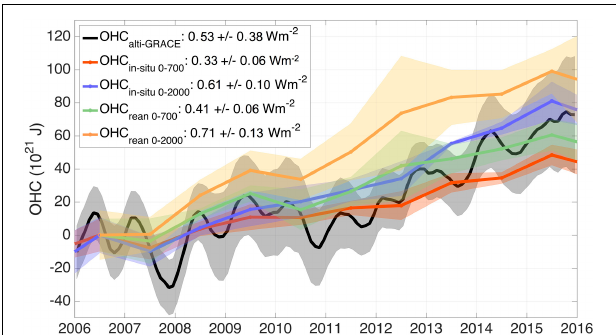
FIGURE 11 | Global mean smoothed (5-month running average) monthly anomalies of OHC derived from alti-GRACE (cid:49) SL thermo (black, OHC alti − GRACE ), annual mean OHC over the 0–700 m ocean column based on six in situ datasets (OHC in situ , red), annual mean OHC over the 0–2000 m ocean column based on four in situ datasets (OHC in situ , blue), annual mean OHC over the 0–700 m ocean column based on three ocean reanalyses (OHC rean , green), annual mean OHC over the 0–2000 m ocean column based on three ocean reanalyses (OHC rean , orange). For OHC rean and OHC in situ , the shading indicates the spread between timeseries (1.65-sigma). The trend uncertainties represent 5-95% CL from weighted least square regression and adjusted degrees of freedom. For OHC rean , the trend is adapted from von Schuckmann et al. (2018). The trend 5–95% uncertainty in OHC alti − GRACE is translated from the trend uncertainty in SLA thermo and uncertainty in ε (see text in section “Estimating the OHC Change From the Ocean Thermal Expansion Change” and Table 3 for